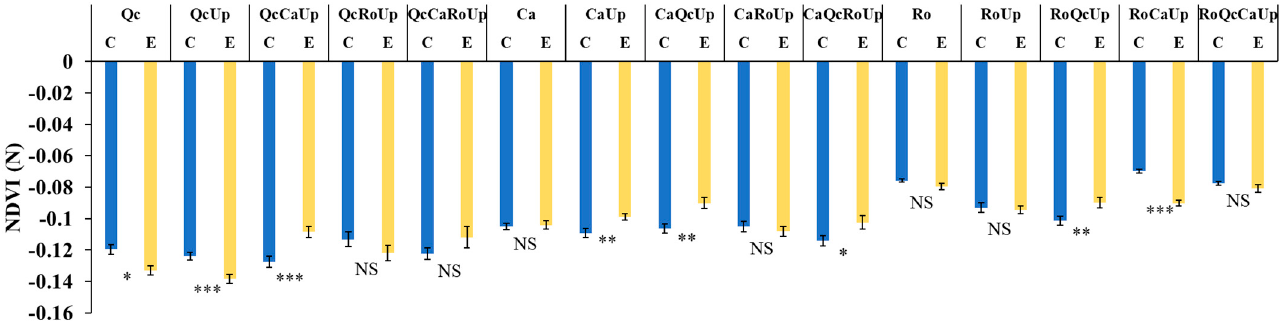
Figure 9. Histograms of nitrogen-content index, NDVI(N) of assemblages in control (C) and rain- exclusion (E) conditions. Quercus coccifera (Qc), Cistus albidus (Ca) and Rosmarinus officinalis (Ro) and Ulex parviflorus (Up). The first two letters of each assemblage indicate the species measured. NS, not significant; * p < 0.05; ** p < 0.01; *** p < 0.001. n = 27.